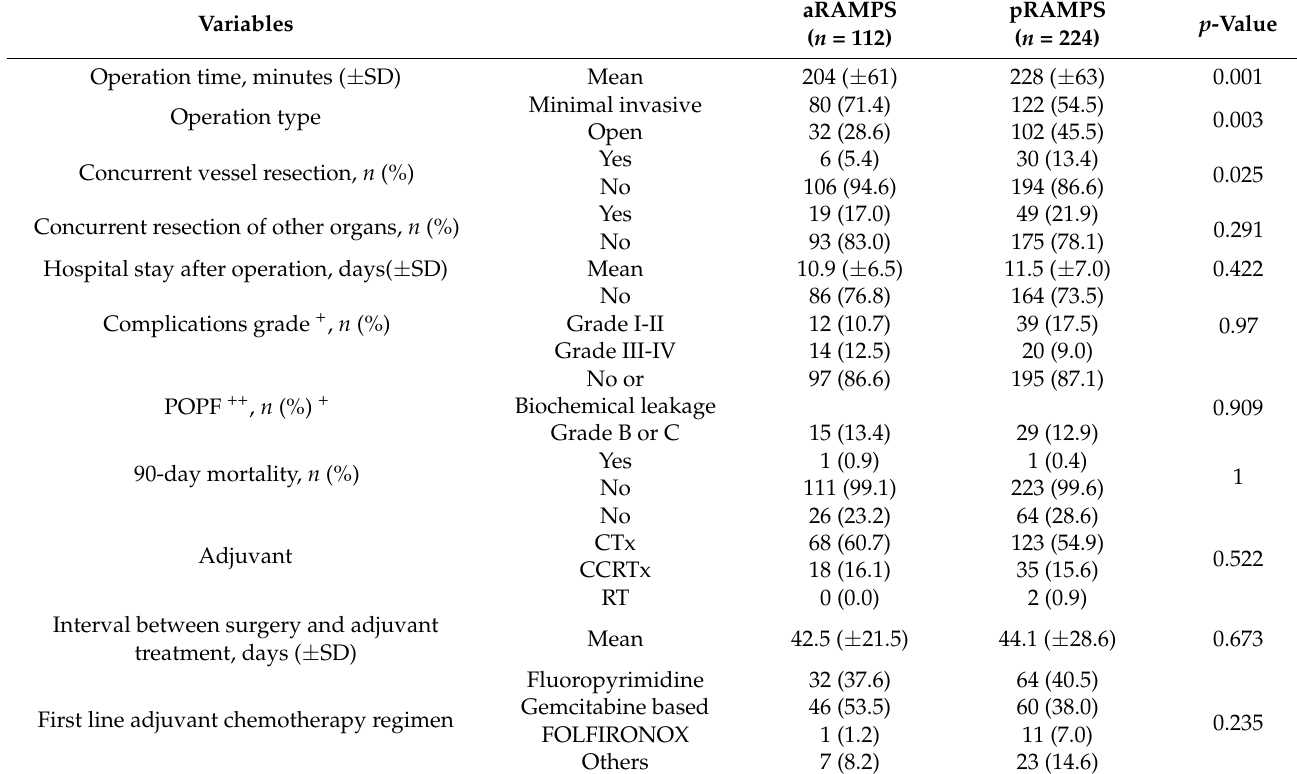
Table 2. Perioperative outcomes of radical antegrade modular pancreatosplenectomy.